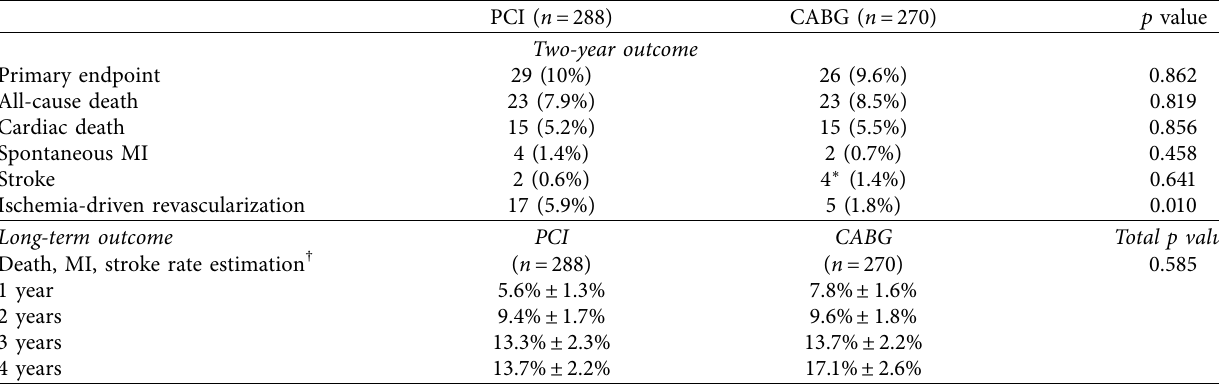
Figure 1: Kaplan–Meier curves for composite primary endpoint according to revascularization strategy by PCI or CABG (overall study population). MI, myocardial infarction; PCI, percutaneous coronary intervention; CABG, coronary artery bypass grafting. Table 3: Clinical